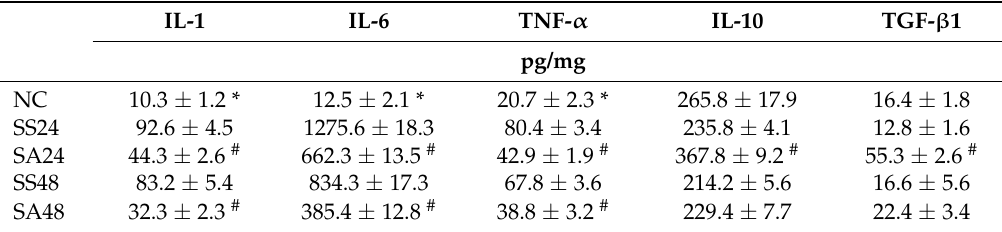
Table 2. Quantitative level of cytokines protein expression in lung homogenates.